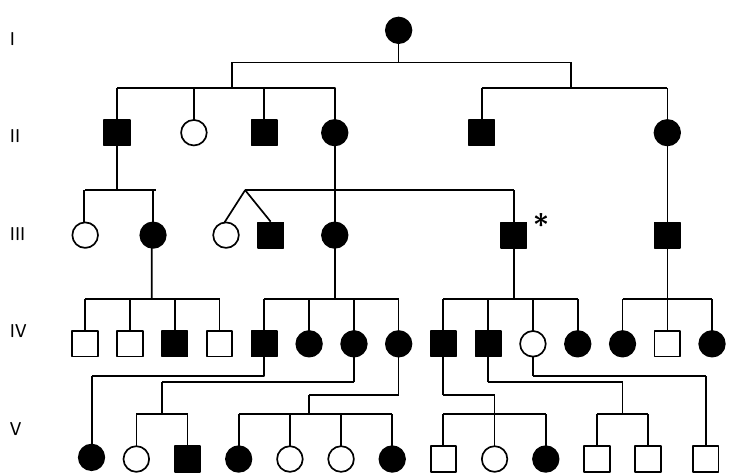
Figure 3. Pedigree of speech impaired family [13]: Filled symbols denote all those members of the family with evidence of SYNS4 and all of those affected that were tested had disruption of TOSPEAK/C8ORF37AS1 [12]. All but one of the affected family members were speech impaired and all of those affected that were tested had malformation of the larynx (Figure 4B,D). The degree of speech impairment varied dramatically between affected family members. All affected family members presented with a degree of bilateral pisiform elongation. Pisiform elongations were near identical bilaterally yet varied markedly in length between affected family members (Figure 4E–K). All affected also had a degree of progressive postnatal vertebral fusion from an early age [13]. Additionally, 6/7 affected females, but none of the males, presented with age-related otosclerosis and conductive hearing impairment [13]. Near 50% of affected family members presented with congenital bilateral fusion of carpal and tarsal joints [13,14,21]. * Indicates the proband referred to in Figure 4.